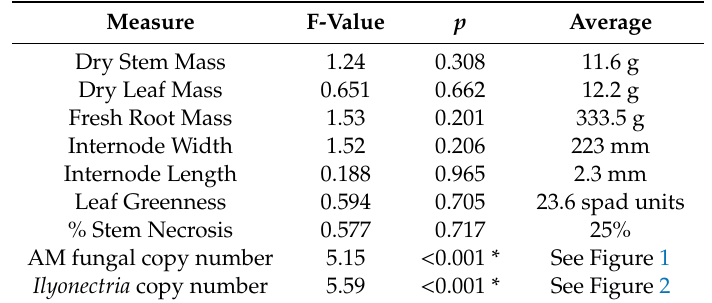
Table 2. Means for plant growth chracteristics and abundance of fungal isolates, six months after inoculations with AM fungi and Ilyonectria isolates. F-values and p -values are the result from ANOVA for inoculation treatment e ff ects (n = 40). Copy numbers of mtDNA (AM fungi) and beta tubulin ( Ilyonectria ) were obtained using molecular-based quantitative digital droplet PCR.